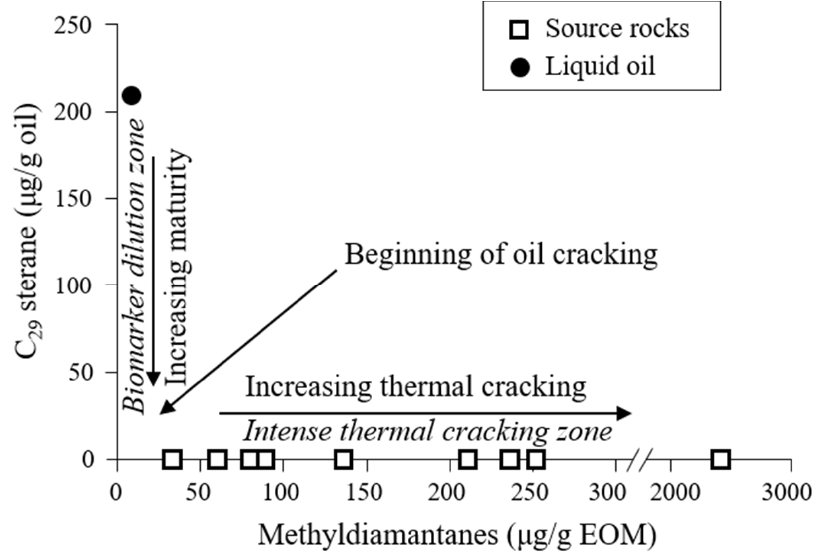
Figure 5. Correlation between the concentrations of methyldiamantanes and C 29 steranes in liquid oil and source rock extracts from well Chaiye 2 showing the degree of thermal cracking.